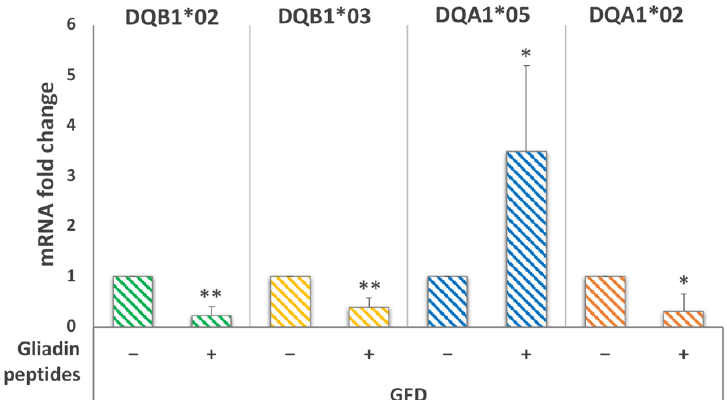
Figure 7. Analysis of DQB1 and DQA1 gene expression after stimulation of M Φ with a pool of glia- din peptides. DQB1*02, DQB1*03, DQA1*05, and DQA1*02 mRNAs fold variation in GFD patients ( n = 5: CD07, CD21, CD24, CD26, and CD55) with the DR5/DR7 genotype after overnight stimulation with a pool of gliadin peptides (* p < 0.05, ** p < 0.01).